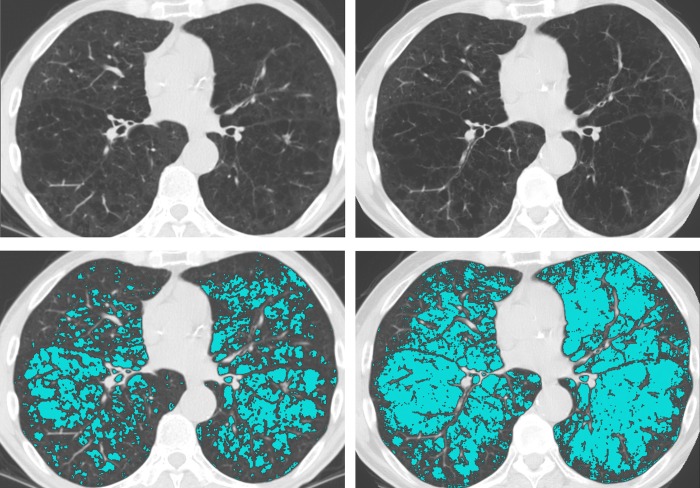
Screenshots of a positive emphysema score progression case.Four screenshots with emphysema score overlays from one participant are displayed. The left-side screenshots are from the baseline scan; the right-side screenshots are from the first annual follow-up scan. The top screenshots are without the emphysema score overlay. This participant had an emphysema score progression rate of 21.6.